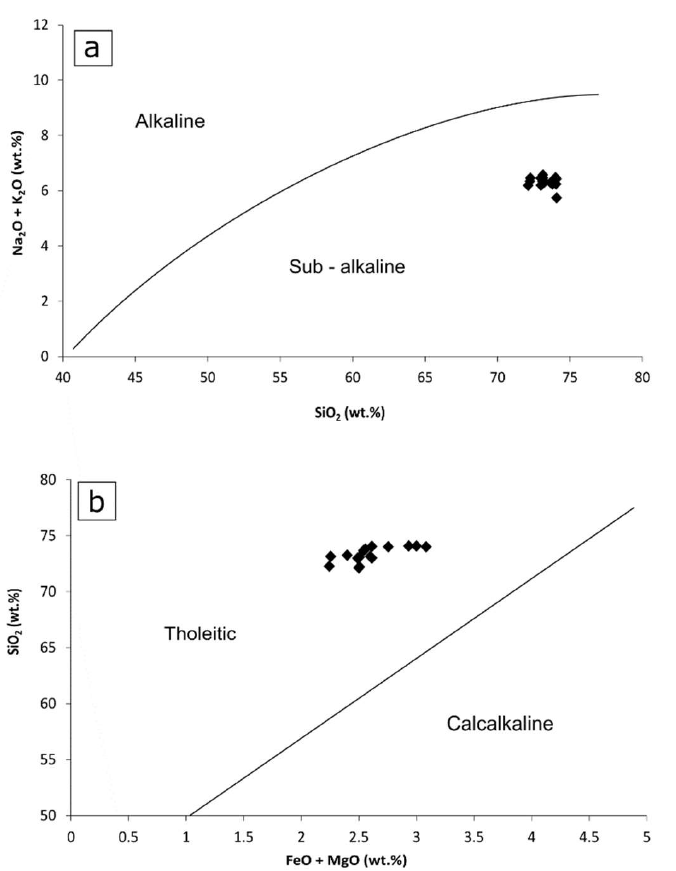
Figure 6. ( a ) SiO 2 (wt.%) vs. Na 2 O+K 2 O (wt.%) variation diagram (modified after [48,54]); ( b ) FeO/MgO (wt.%) vs. SiO 2 (wt.%) variation diagram (modified after [55]). The FeO/MgO vs. SiO 2 diagram [55] (Figure 6b) shows that all samples fall in the tholeiitic compositional field with FeO/MgO values ranging from 2.26 to 3.10. Finally, in the SiO 2 vs. K 2 O diagram [56] (Figure 7) the analyzed rocks, showing K 2 O between 1.36 and 1.60 wt.%, plot into the continental trondhjemite field.